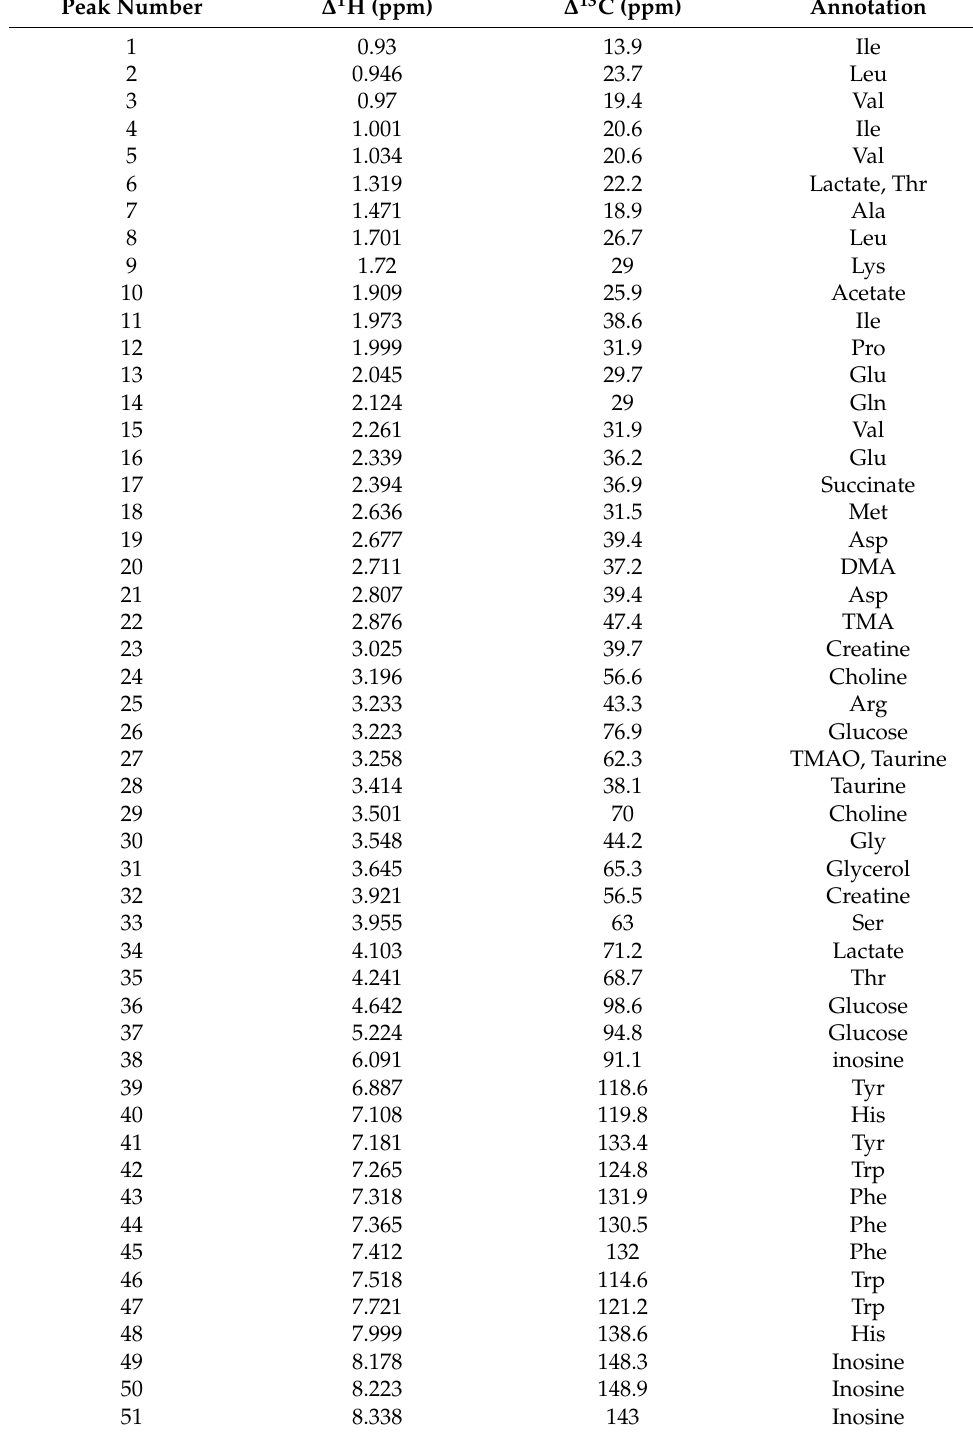
Table 2. NMR signal annotation of gut contents of fish extracts using KPi/D 2